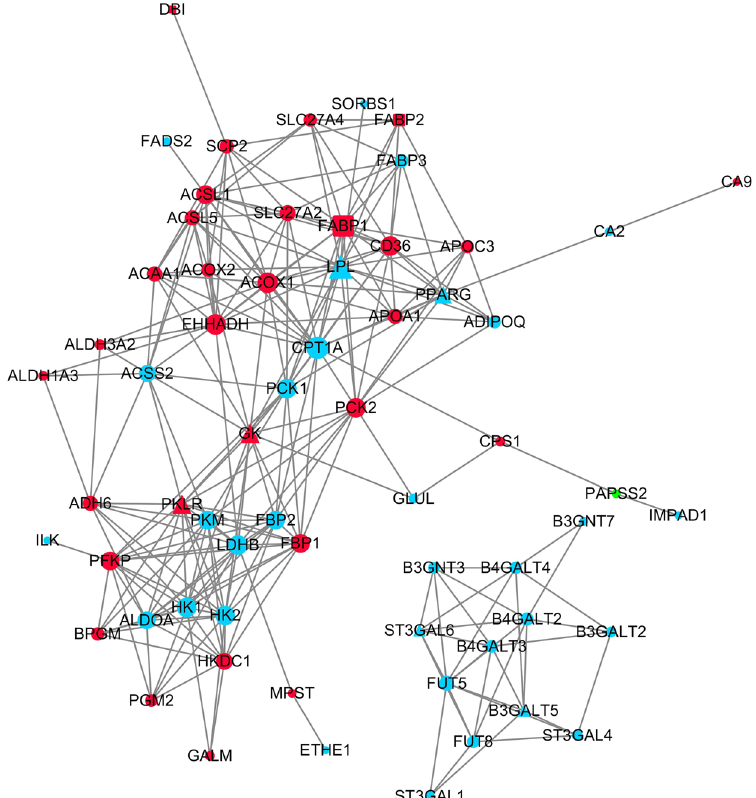
Figure 3. Protein-protein interaction networks of metabolism related pathway enriched genes. The node size was decided on the basis of the interaction degree value of each gene. Triangle node: FPKM < 10 in all intestinal regions; Circular node: 10 ≤ FPKM < 500 in at least one tissue with the highest expression; Square node: FPKM ≥ 500 in at least one intestinal tissue. Red: Higher expressed in the duodenum; Blue: Higher expressed in the large intestine; Green: Multiple transcript expression patterns are not